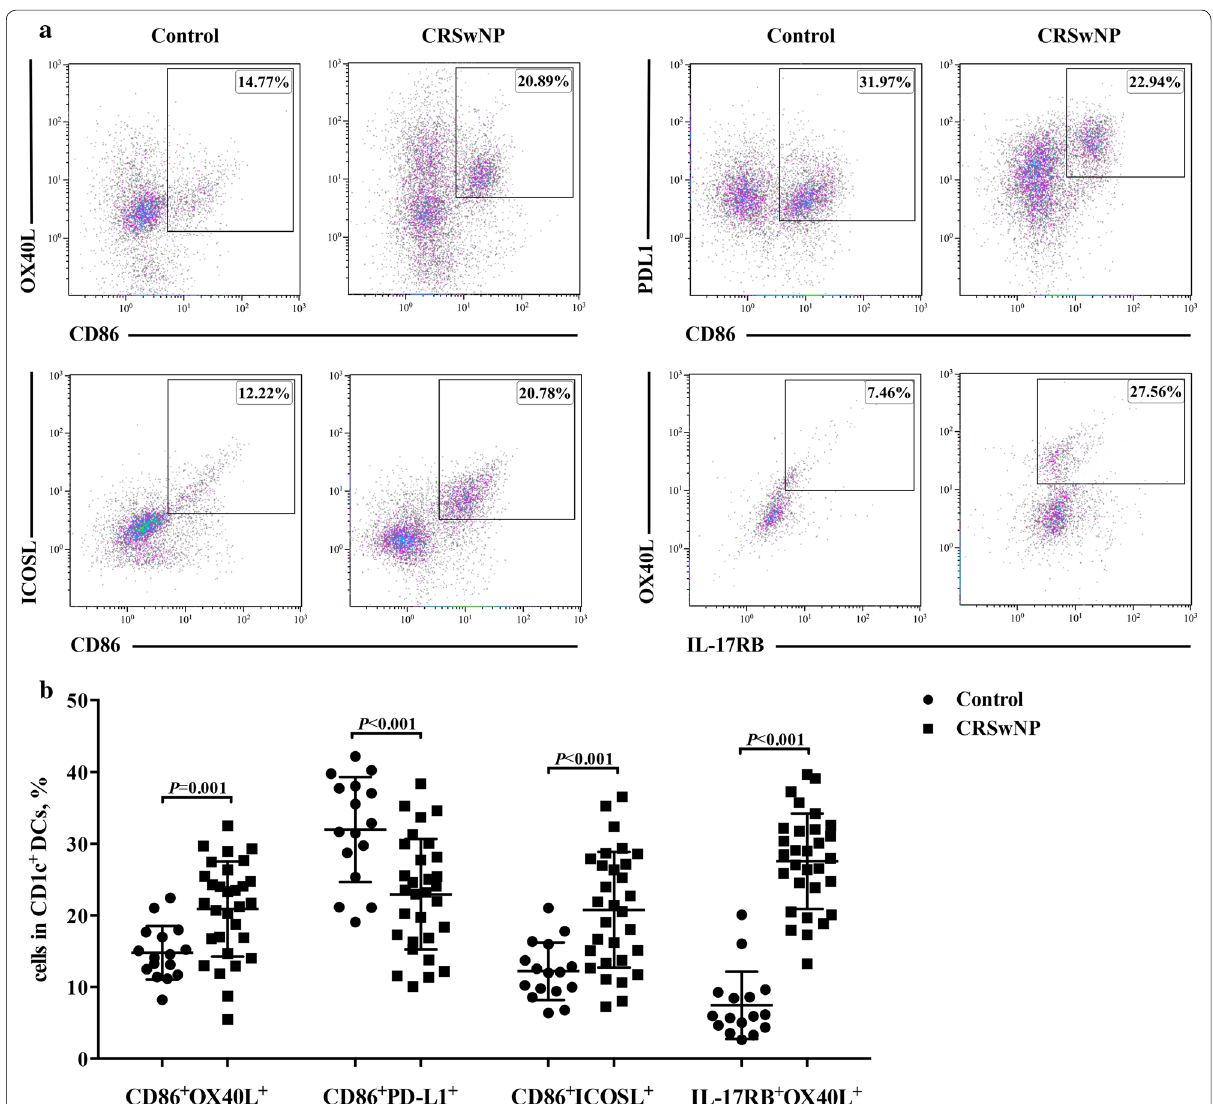
Fig. 4 Expressions of OX40L, PDL1 and ICOSL on activated CD1c + DCs in NP tissues. Representative flow‑cytometry pseudocolor density plots, in which gray‑pink‑blue indicates increasing cell density, showing the percentages of CD86 + OX40L + , CD86 + PDL1 + , CD86 + ICOSL + and IL‑17RB + OX40L + cells in CD1c + DCs in nasal tissues from healthy controls (n CD86 + OX40L + , CD86 + PDL1 + , CD86 + ICOSL + and IL‑17RB + OX40L + cells in CD1c + DCs ( b ). Data are presented as a percentage of the positive cells in CD1c + DCs and mean with SD or median with